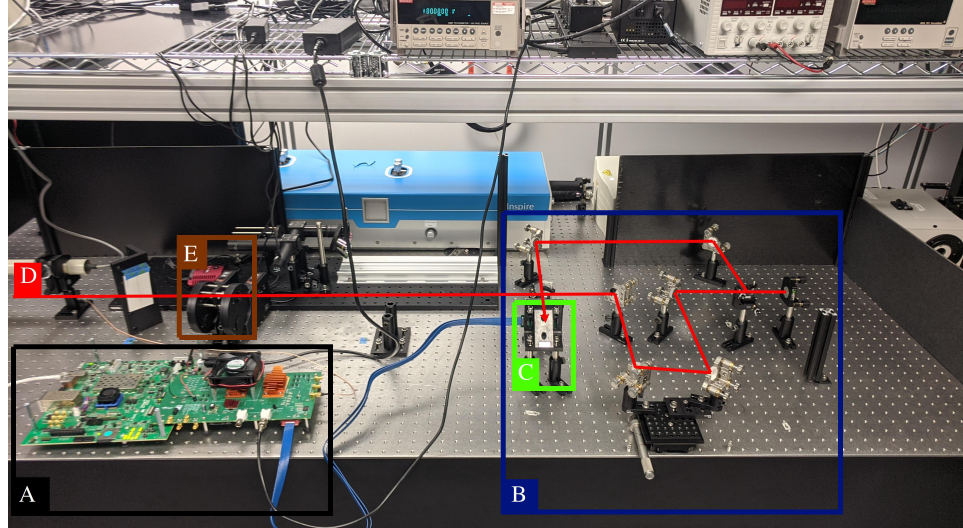
Figure 11. Laboratory setup for the Mach–Zehnder interferometer. The femtosecond laser comes in from the left ( D , red). On the left, there is also the control board ( A , black) for the detector from Figure 8. On the right is the MZI optical setup ( B , blue) with the detector ( C , green) in the middle, facing back. The optical setup ( B , blue) is the same as the schematic of Figure 10. The neutral density filters ( E , brown) can adjust laser